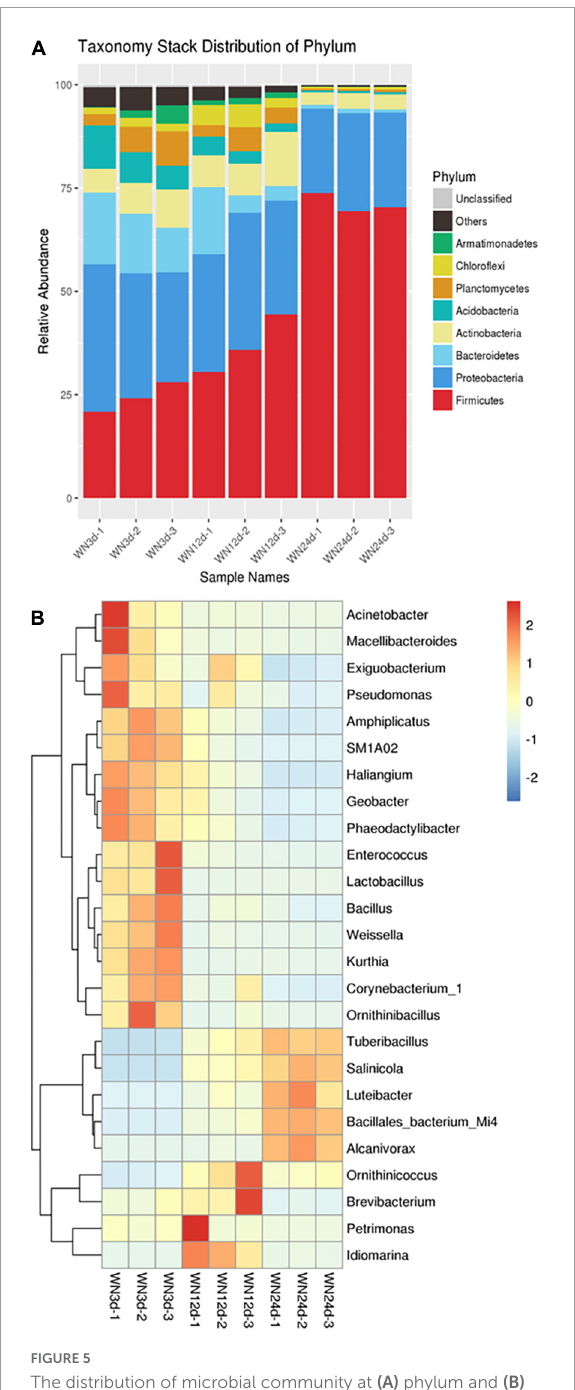
FIGURE5 The distribution of microbial community at (A) phylum and (B) genus levels during the composting process.